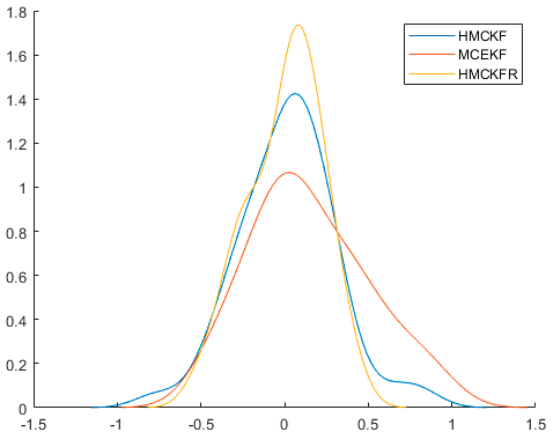
x estimation errors with the three filters in case 2.